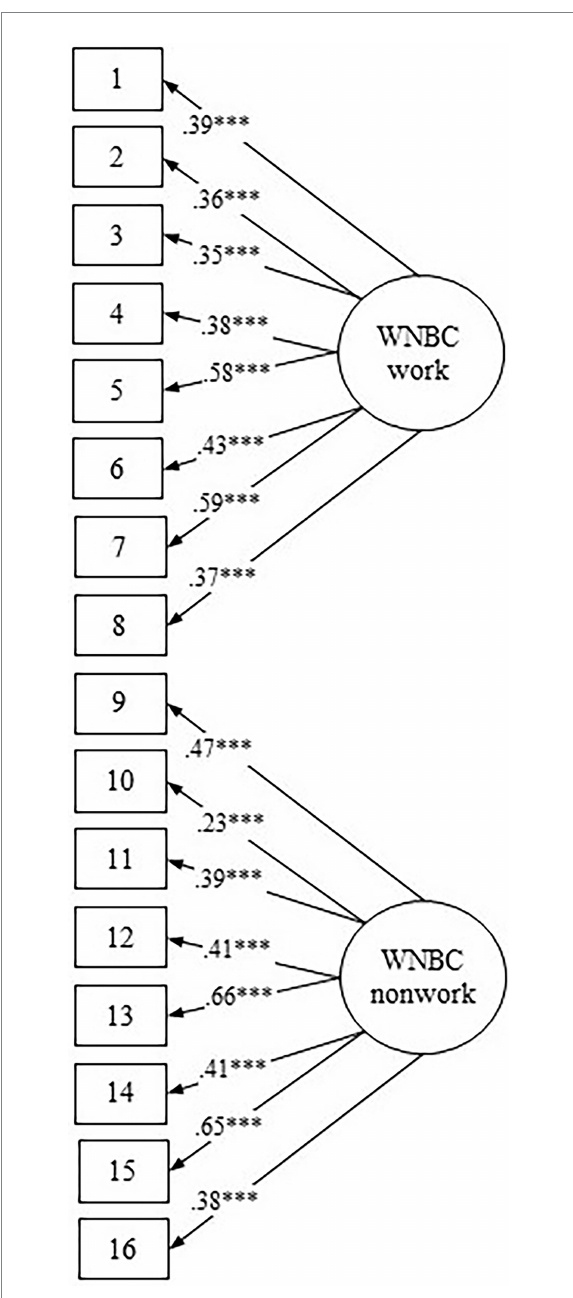
FIGURE 1 Configuration of WNBC scale with two-factorial CFA solution as presented in study 3. Latent constructs are shown in ellipses, and observed variables are shown in rectangles. Numbers in rectangles refer to WNBC scale item numbers, as presented in Table 1. *** p <